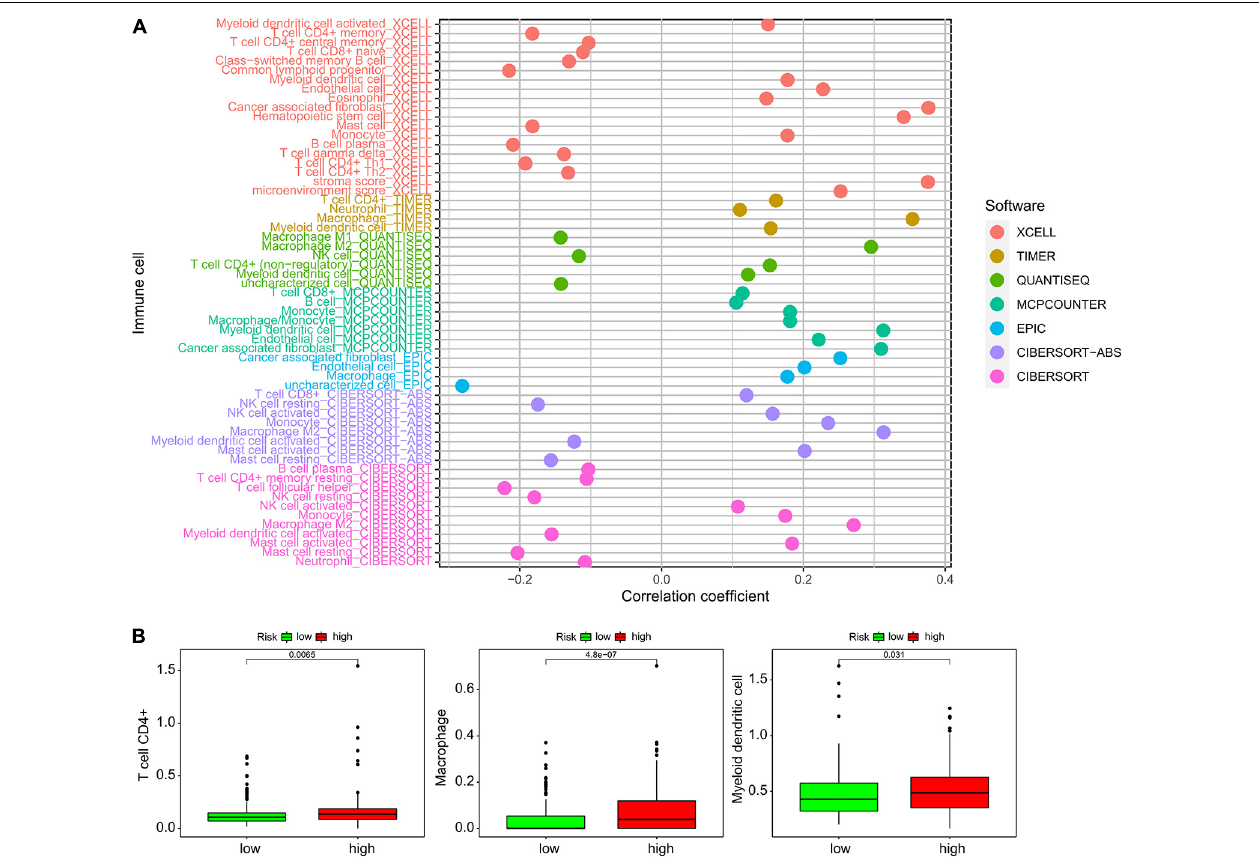
FIGURE 5 | Association of ImmiRSig with chemotherapy response. (A) Paclitaxel IC 50 between high- and low-risk patients with GC (B) sorafenib IC 50 between high- and low-risk patients with GC.